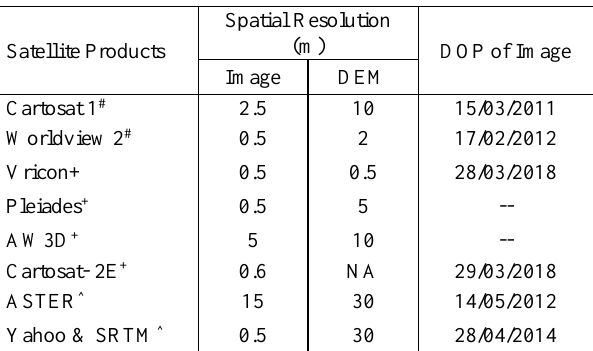
Table 1 ( # Commercial stereo data processed at DTRL, + Commercial product, ^Open source-